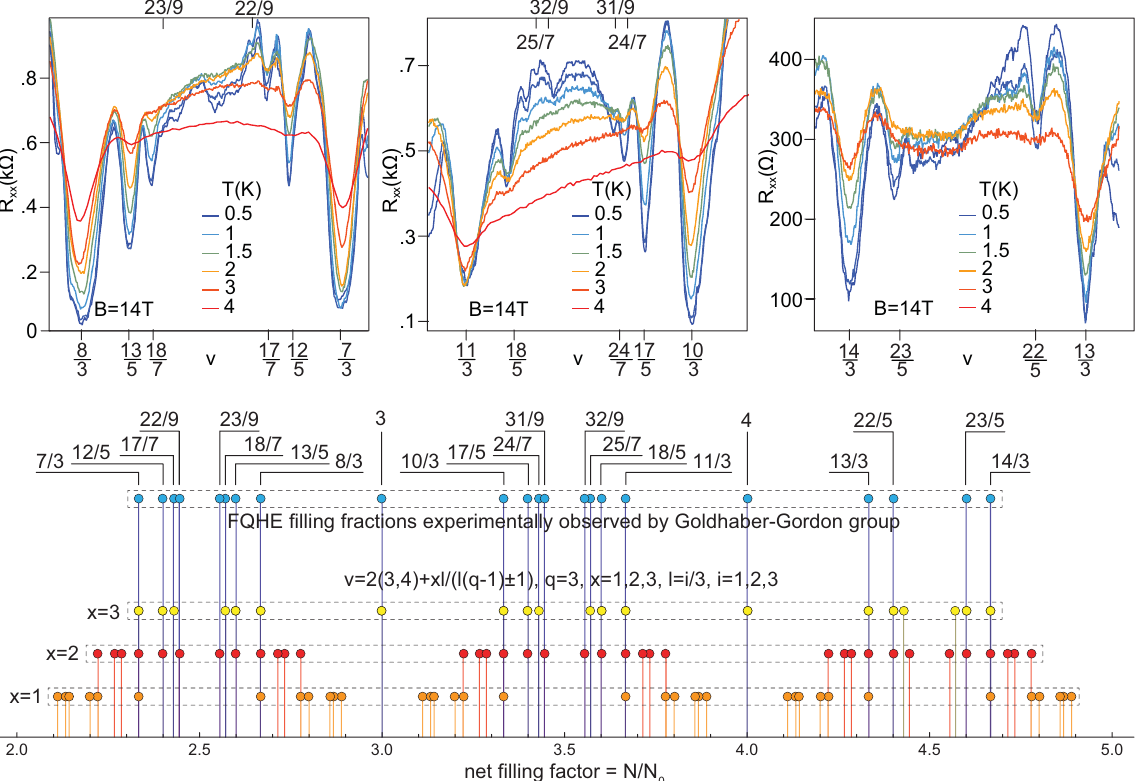
Figure 1. Fitting to experimental data of cyclotron braid hierarchy for FQHE in monolayer graphene in the first three subbands in the first LL ( n = 1), ν ∈ (2, 5] . Upper panel— R xx after experiment 10 , lower panel—the theoretical hierarchy. The larger residual longitudinal resistance (in the upper panel for fractions with denominators 5, 7, 9) corresponds to correlated states of next-nearest electrons, of every second ( x = 2) or every third ( x = 3) particle, according to the commensurability series ν = (lower panel) ( x = 1 corresponds to CF-like commensurability)— uncorrelated electrons enhance